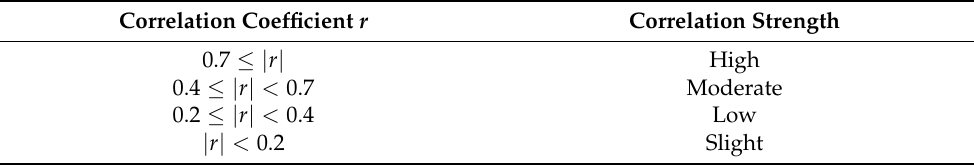
Table 3. Classification of correlation